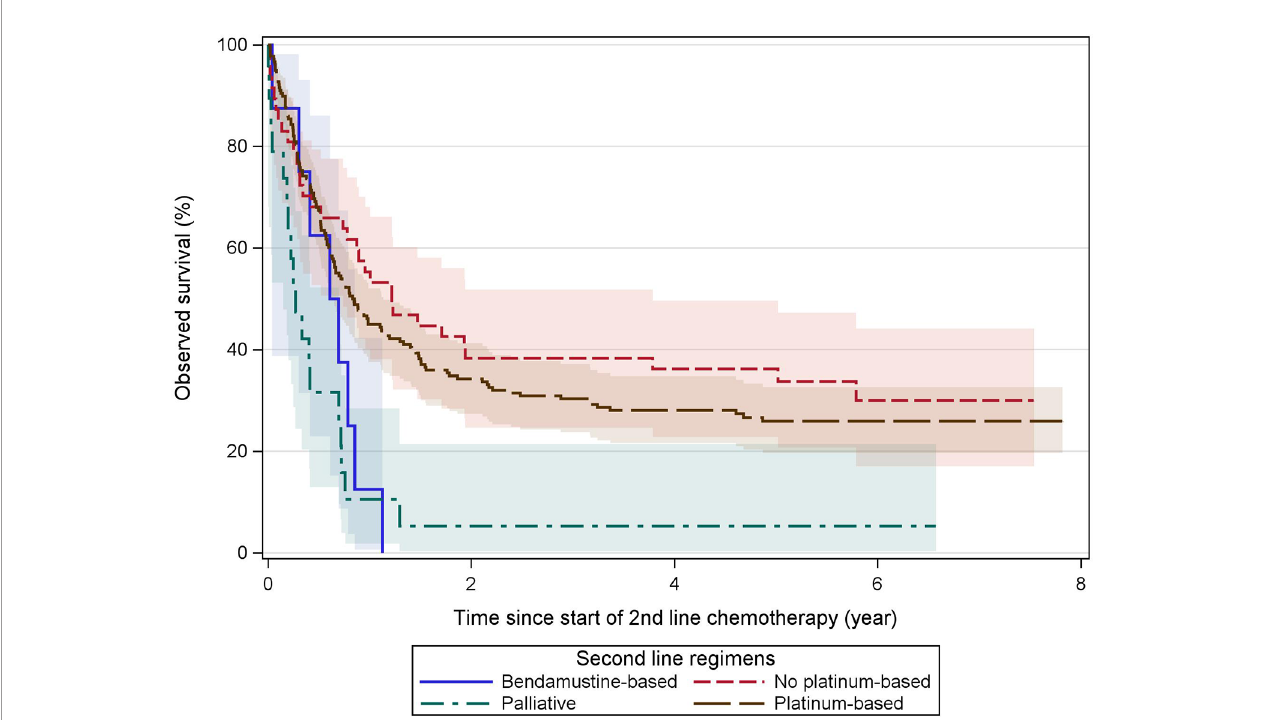
FIGURE 4 | Observed survival after second-line treatment. These Kaplan – Meier curves show the observed survival from the start of second-line treatment grouped by treatment categories. Patients receiving subsequent ASCT and/or AlloSCT are included. Both platinum and non-platinum-containing regimens are associated with a similar but limited long-term overall survival. Palliative and bendamustine-containing regimens provided (nearly) no survival beyond the 1-year mark. Colored areas represent the 95% con fi dence